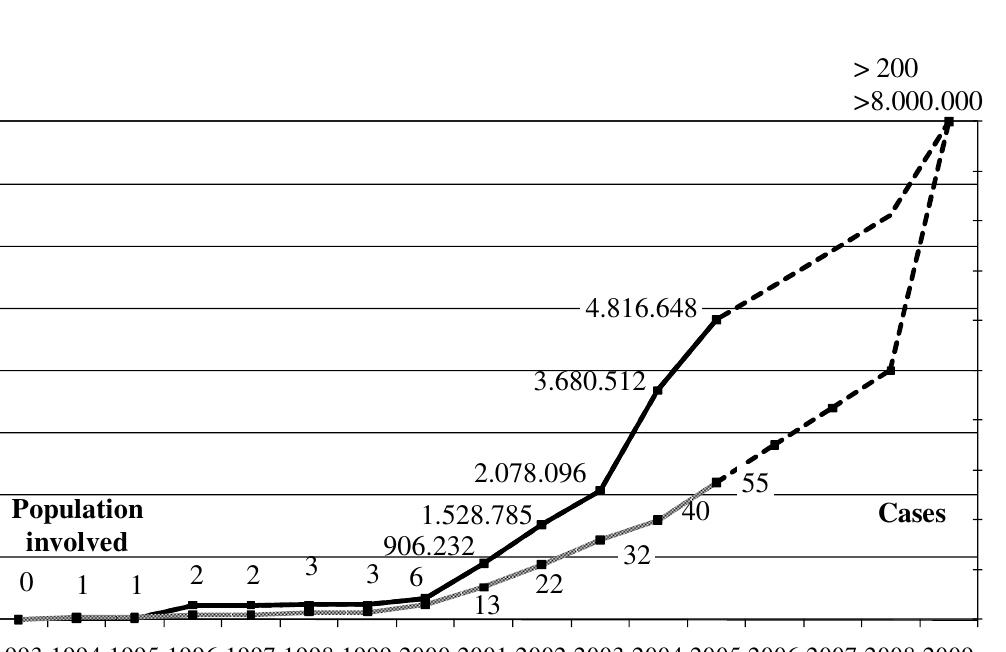
Figure 2: Number of participatory budgets in Europe and population involved